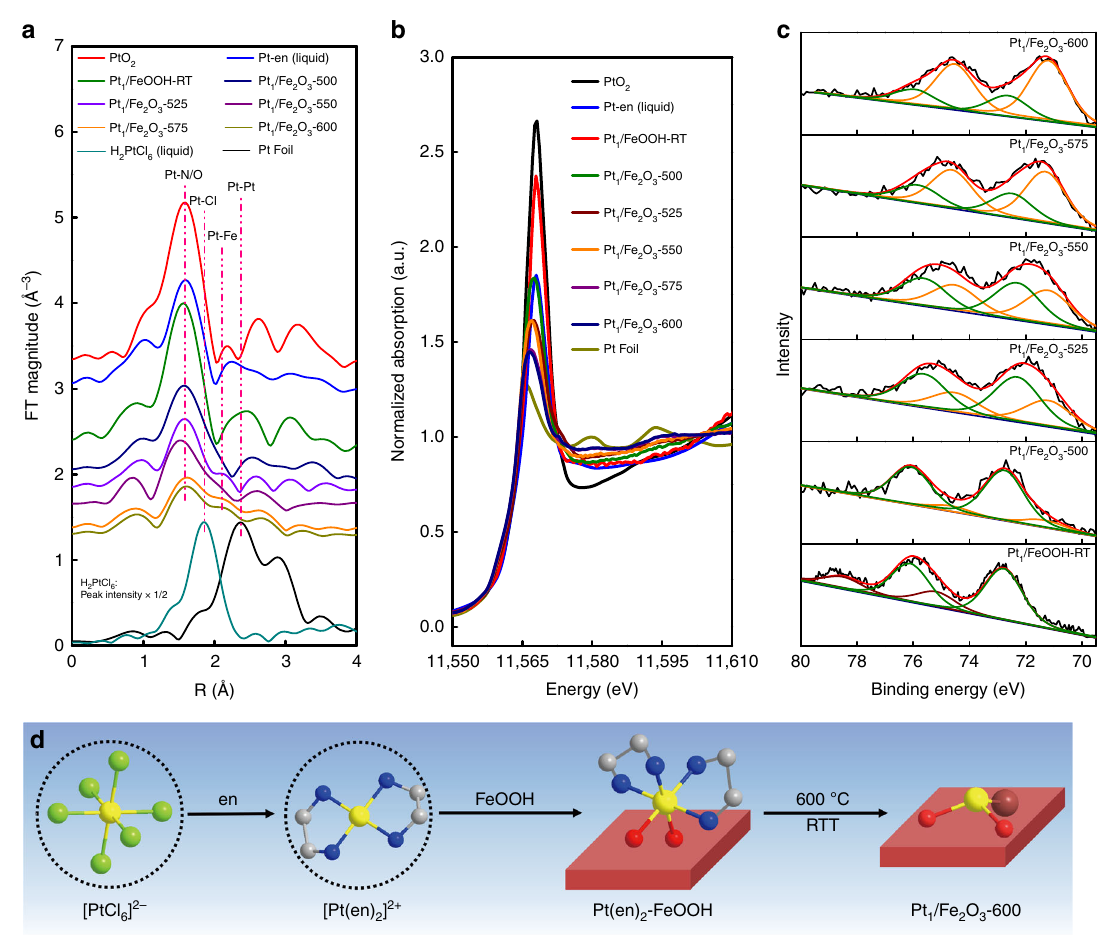
Fig. 3 The Pt L III -edge XAS and Pt 4 f XPS data of the Pt 1 /Fe 2 O 3 -T catalysts. a The Fourier-transformed k 2 -weighted EXAFS spectra in R-space (without phase correction), b the normalized XANES spectra, c the Pt 4 f XPS spectra, and d schematic representation of the structure evolution of Pt species in different stages of preparation. Color codes: yellow (Pt), green (Cl), blue (N), gray (C), red (O), and brown (Fe)